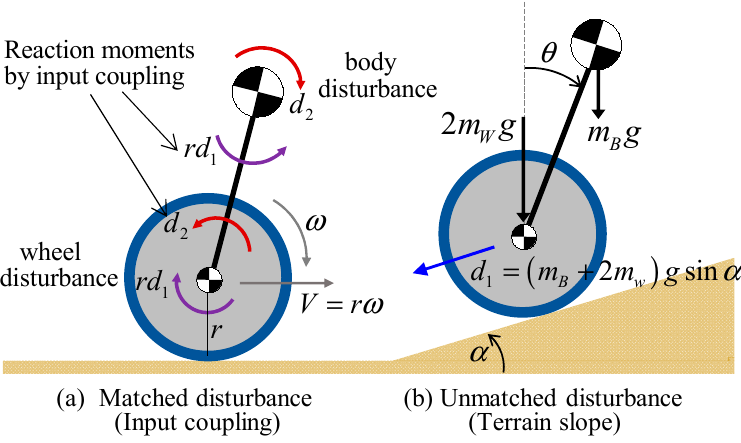
which indicates that the matched disturbances are completely rejected through the input channels if all the states in Equation (4) can be exactly reconstructed in real time.